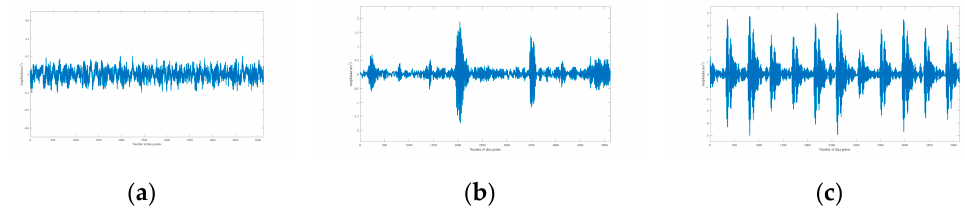
Figure 12. Simulation signals combined without noise. ( a ) Normal; ( b ) roller fault; ( c ) outer ring fault at 6:00 position relative to the load center.